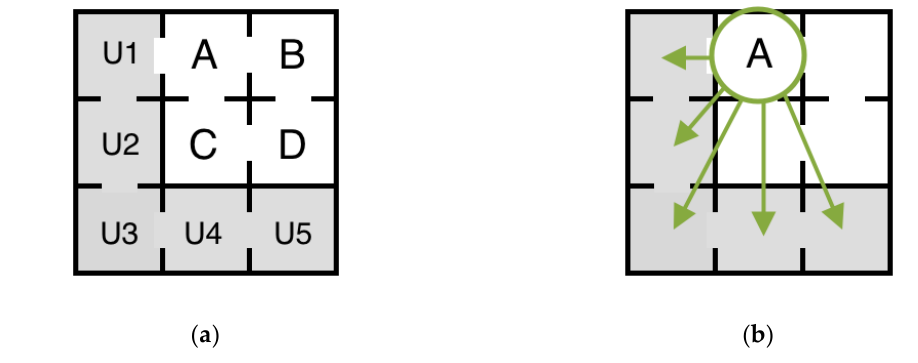
Figure A1. ( a ): Experimental systems showing the disturbed patches, A–D in white, and undisturbed patches, U1–U5 in grey; ( b ): Example showing the patches (indicated by arrows) used to calculate configuration at the patch scale for a disturbed patch, A (circled).